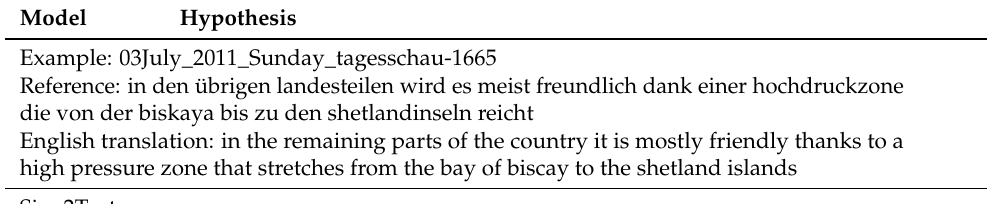
Table 3. Example hypotheses generated by the median BERT2RND ff model and the Baseline model. English translations are obtained using Google Translate (1 out of